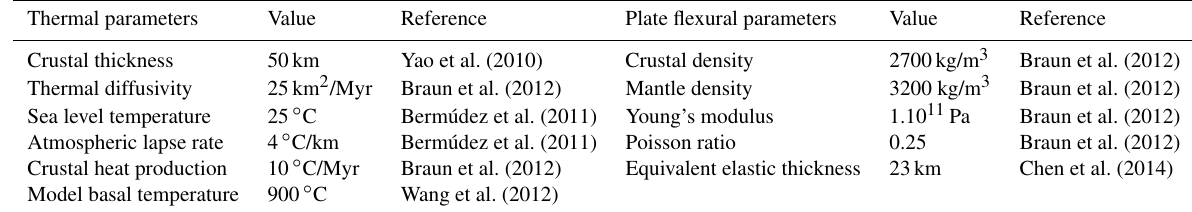
Table 1. Thermal and flexural parameter values for Pecube modelling. Thermal parameters Value Reference Plate flexural parameters Value Reference Crustal thickness 50km Thermal diffusivity 25km 2